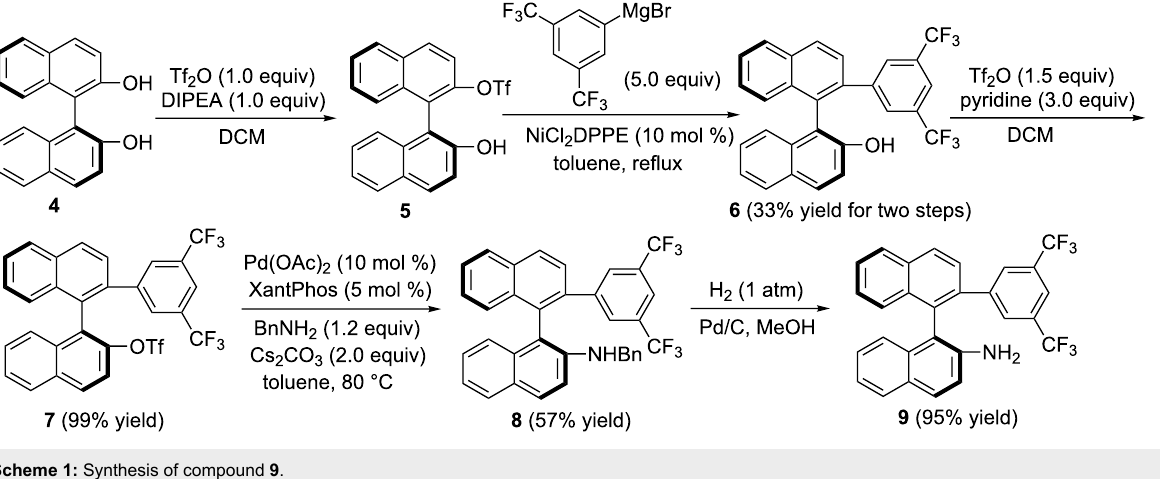
Scheme 1: Synthesis of compound 9